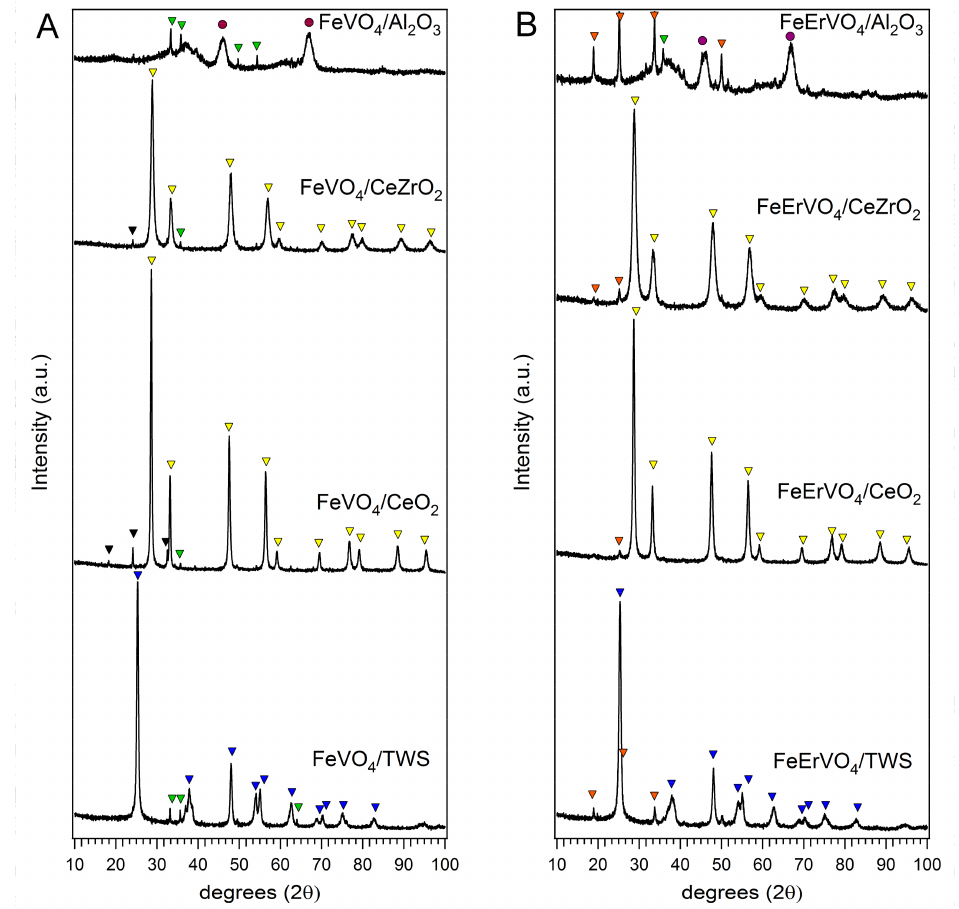
Figure 1. XRD patterns of ( A ) 8.4 wt % FeVO 4 and ( B ) 8.4 wt % Fe 0.5 Er 0.5 VO 4 on different supports. TiO 2 -anatase, Fe 2 O 3 , CeO 2 or CeZrO 2 , (cid:72) CeVO 4 , ErVO 4 , Al 2 O 3 .